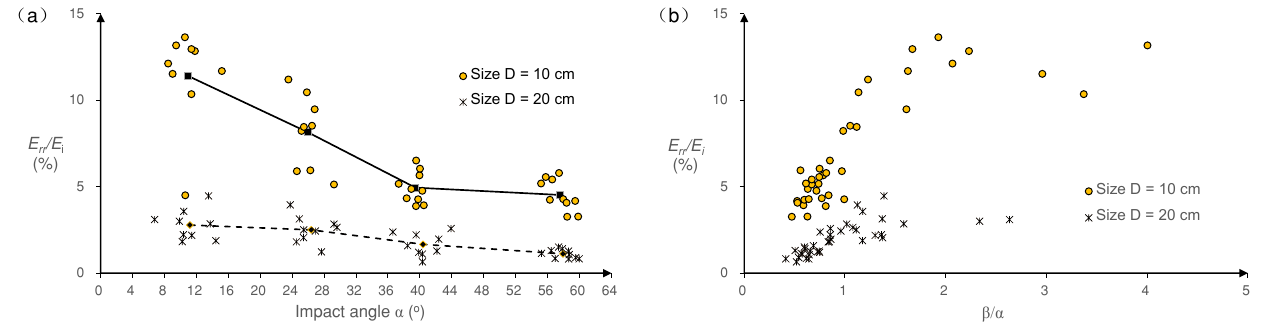
Figure 10. The effect of (a) the impact angle and (b) the ratio β/α on E rr /E i .